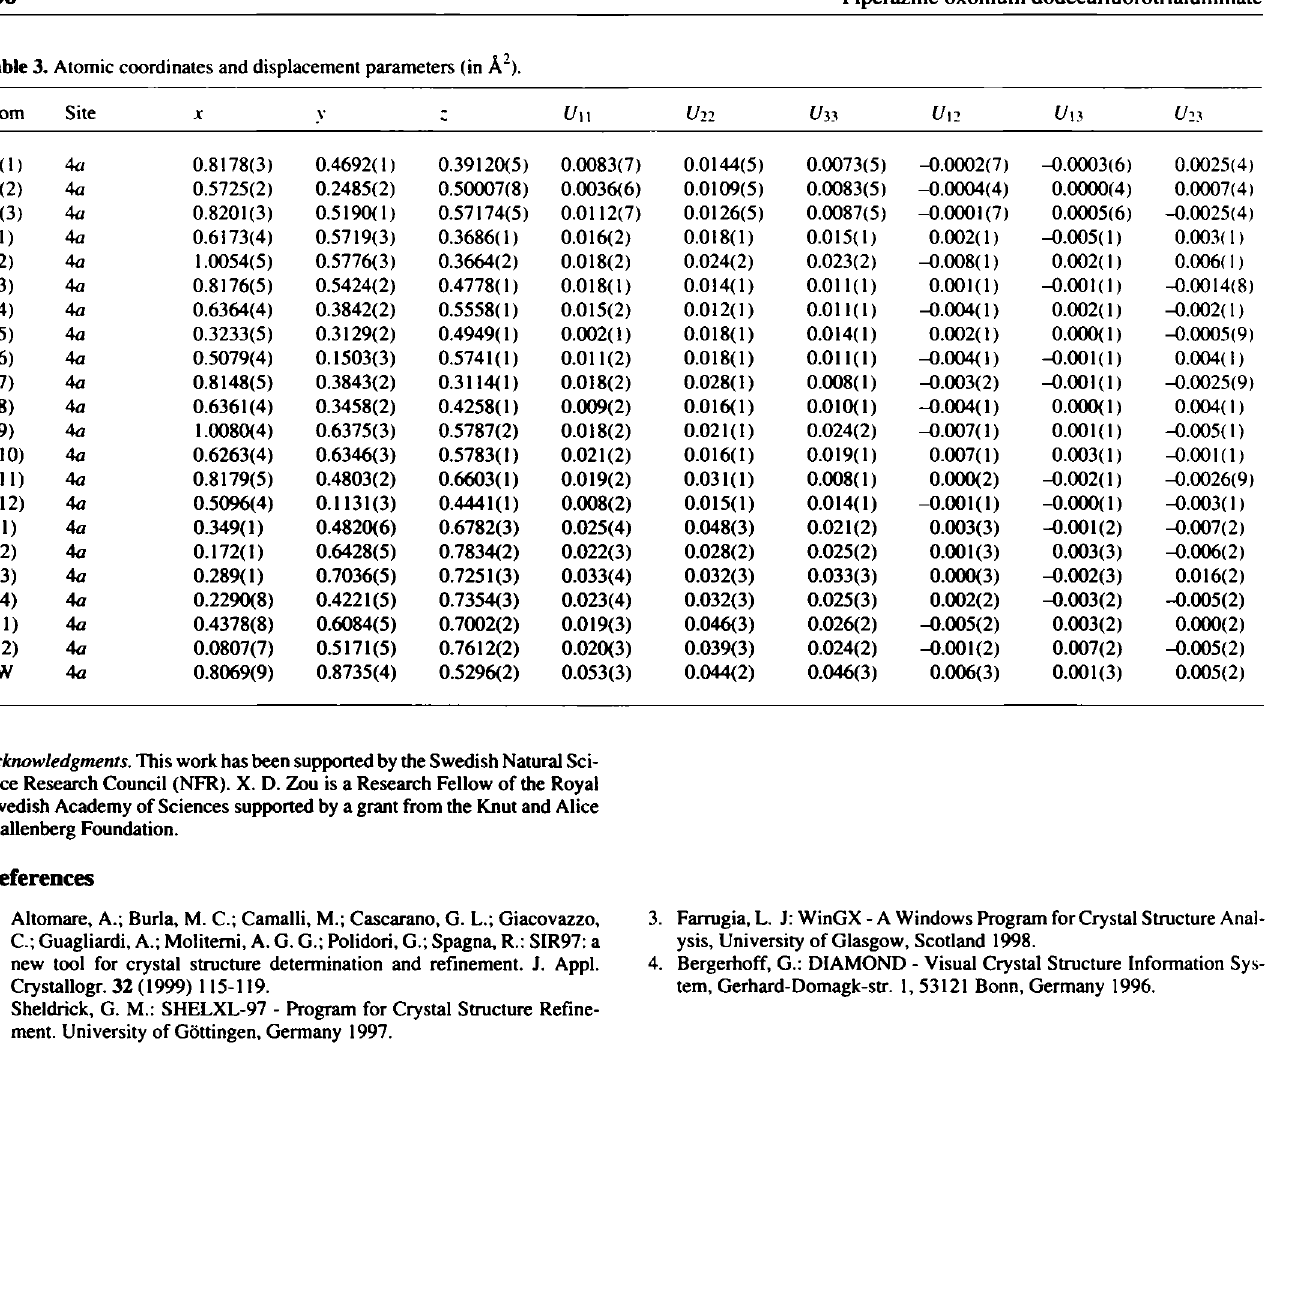
Table 3. Atomic coordinates and displacement parameters (in A 2